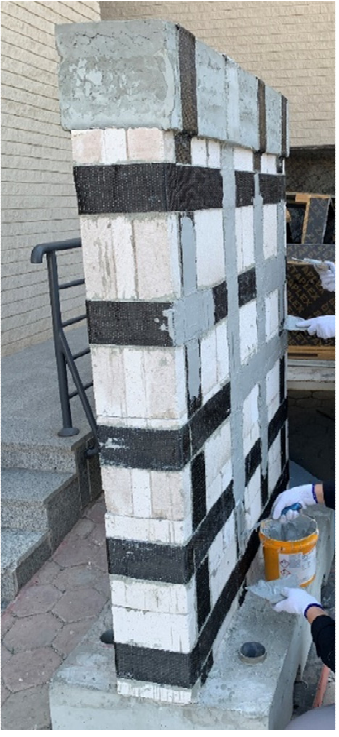
Figure 12. Installation of the CFRP laminates with epoxy resin.